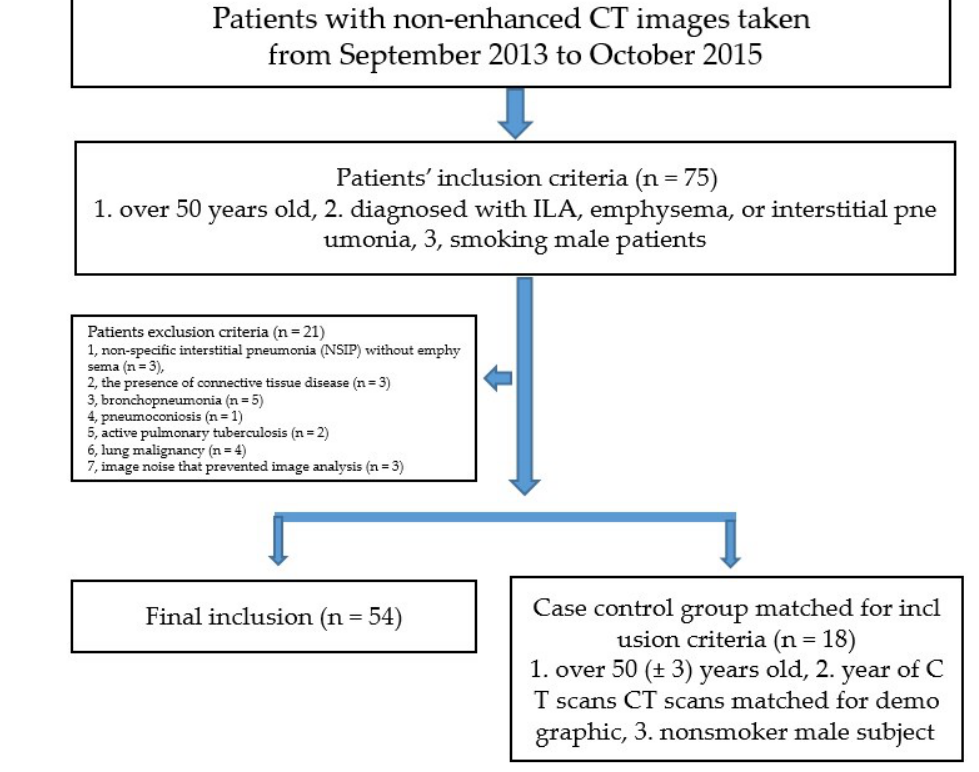
Figure 1. Flow chart of the study population.